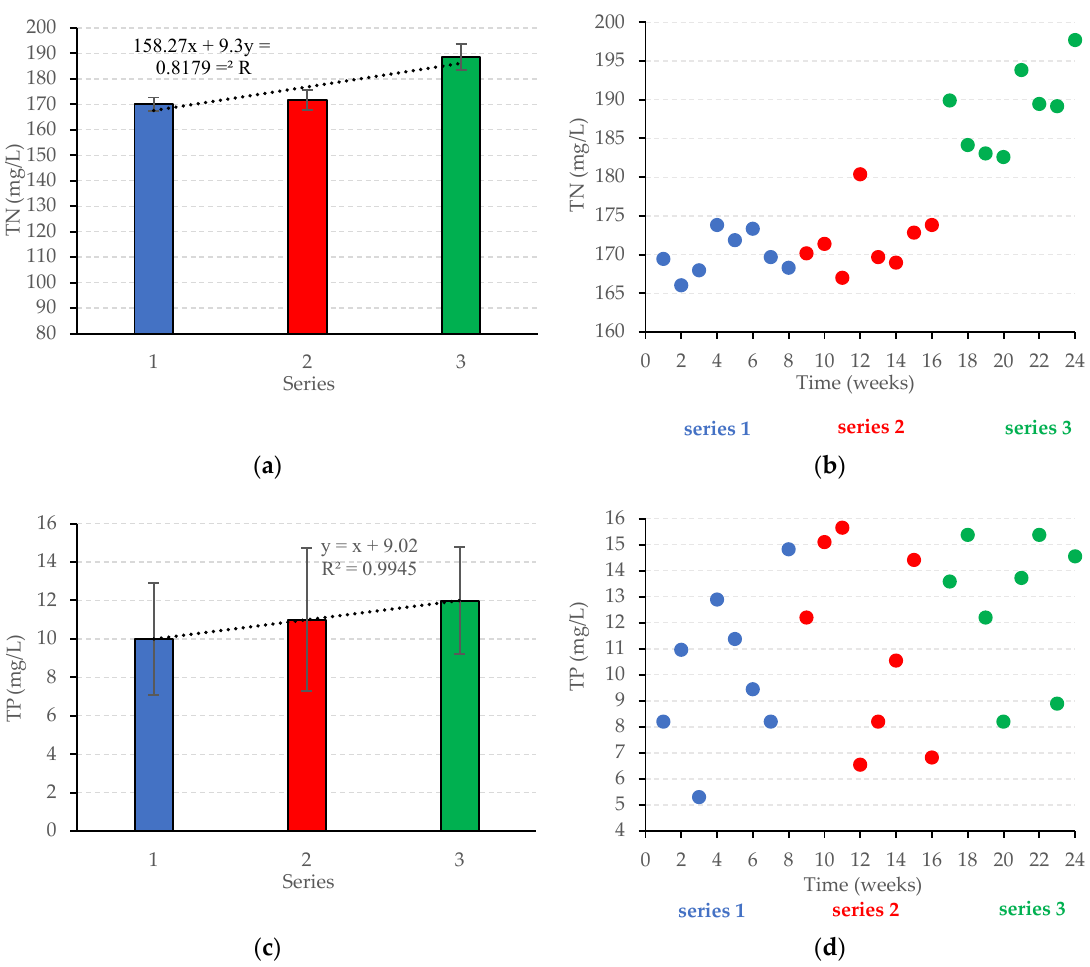
Figure 8. The efficiency of anaerobic confectionery wastewater treatment in stage 2: ( a ) average total nitrogen (TN) concentration with the standard deviation; ( b ) total nitrogen (TN) concentration during experimental time; ( c ) total phosphorus (TP) concentration with the standard deviation; ( d ) total phosphorus (TP) concentration during experimental time.